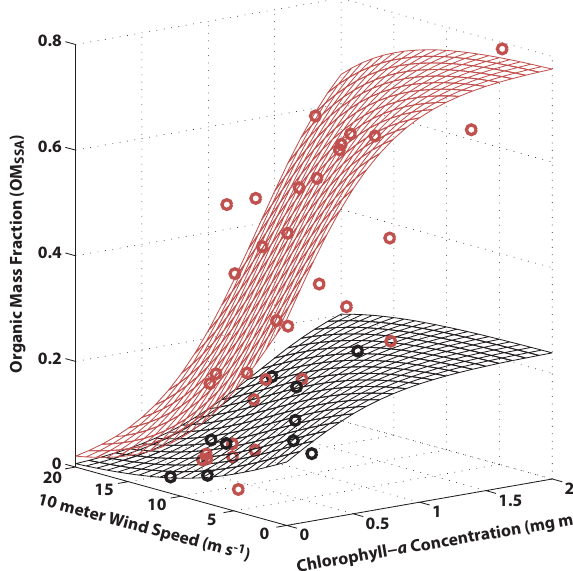
Fig. 3. Organic mass fraction of sea spray aerosol as a function of both 10m wind speed and [Chl- a ] for (a) Mace Head (red) and Point Reyes (black) with the surface regression based on Eq. (1) in the same color scheme for each